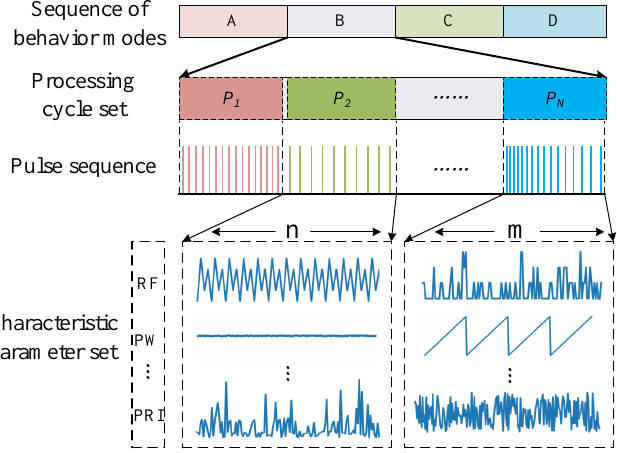
Figure 3. Hierarchical model of radar pattern recognition